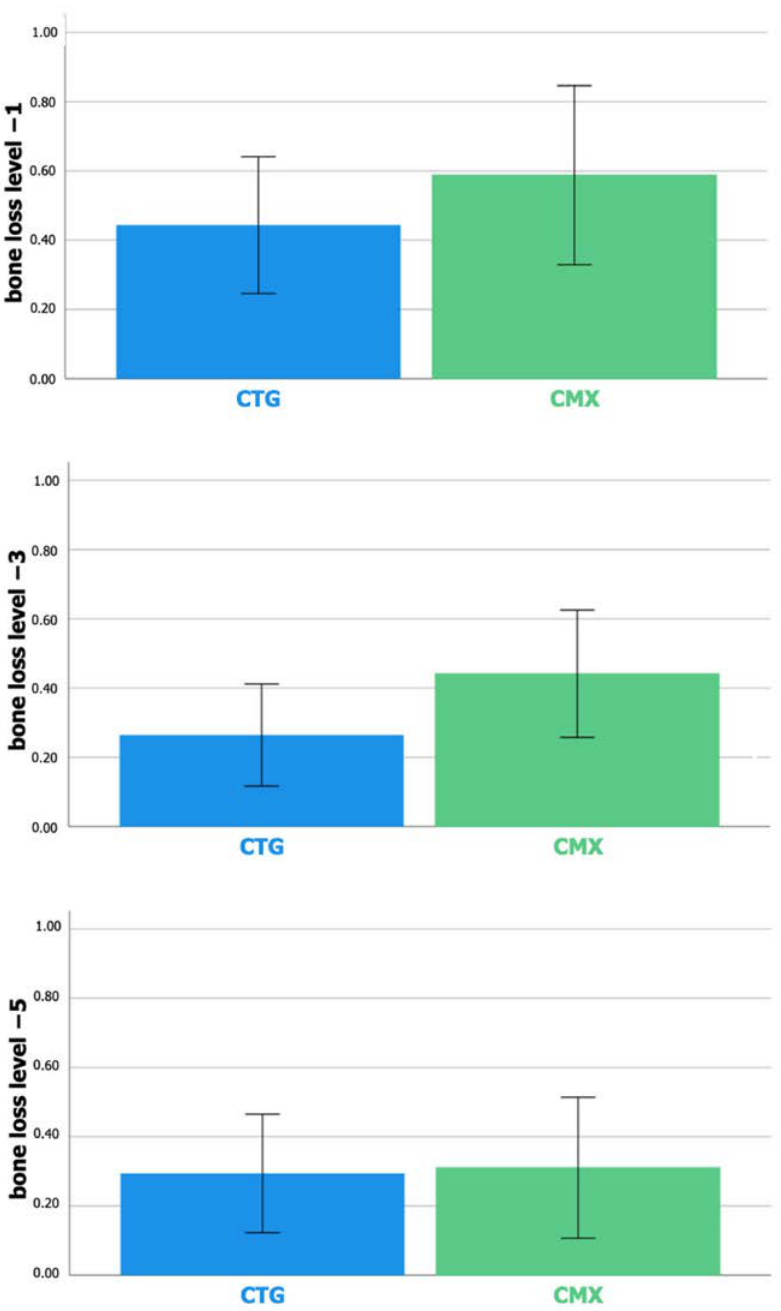
Figure 4. Bar charts representing mean horizontal buccal bone loss at 1 mm, 3 mm and 5 mm apical to the implant-abutment interface, respectively. Error bars: 95% confidence interval.